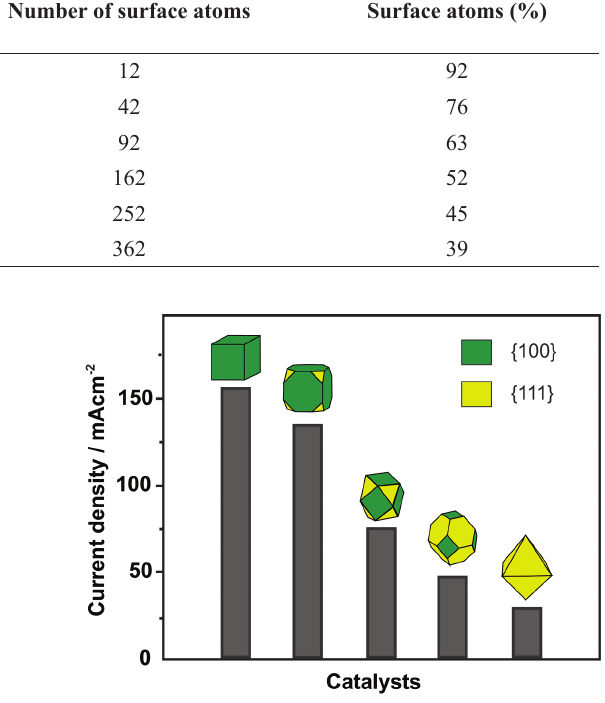
Figure 2 - Maximum current densities for formic acid oxidation employing Pd nanocrystals displaying controlled shapes as electrocatalysts. Adapted with permission from ref. (Jin et al. 2012) Copyright 2012 Royal Society of